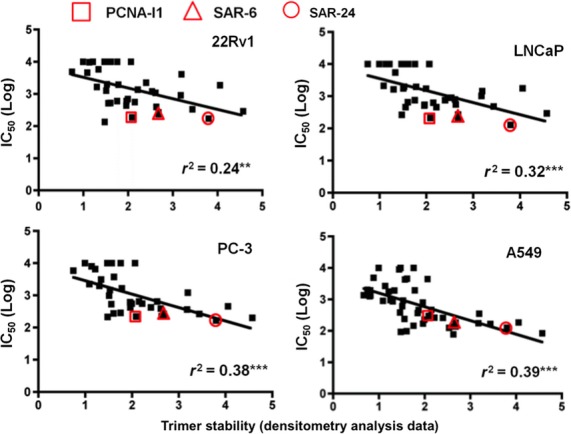
Correlation between growth inhibitory effects (IC50, nmol/L) of SAR compounds and trimer stability determined by linear regression analysis, r2 values are indicated as significantly different from zero by **P < 0.01 and ***P < 0.001. The location of PCNA-I1, SAR-6, and SAR-24 are indicated on the plot.